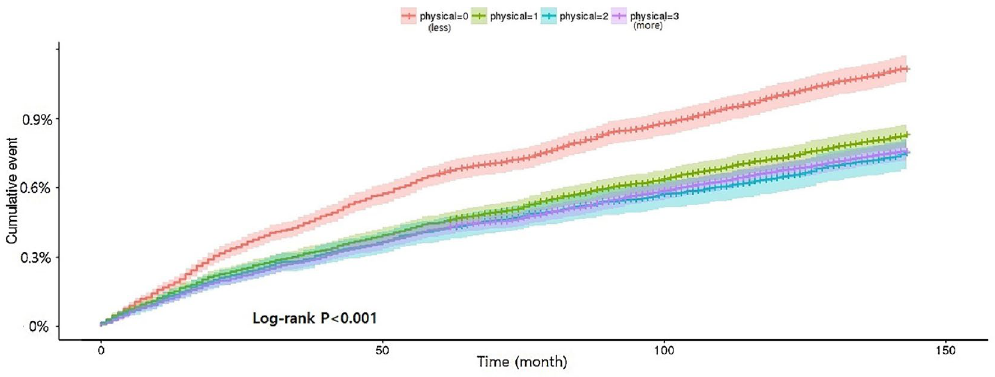
Figure 2. Cumulative incidence rate of seropositive rheumatoid arthritis according to daily physical exercise levels. Physical 0, non-regular exercise; physical 1, mild regular exercise; physical 2, moderate regular exercise; physical 3, high regular